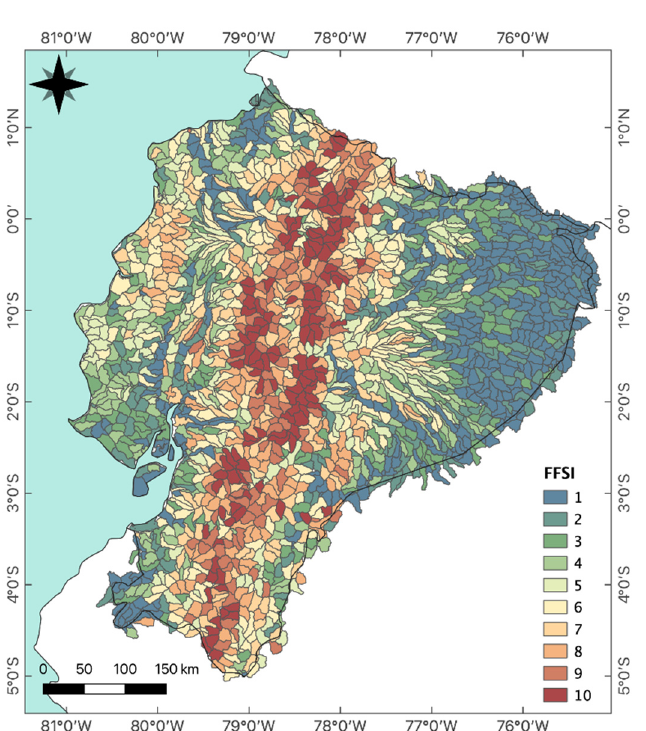
Figure 4. Result of the flash flood susceptibility index (FFSI) applied to continental Ecuador, as a composite map indicating relative susceptibility at the catchment level to flash flood.